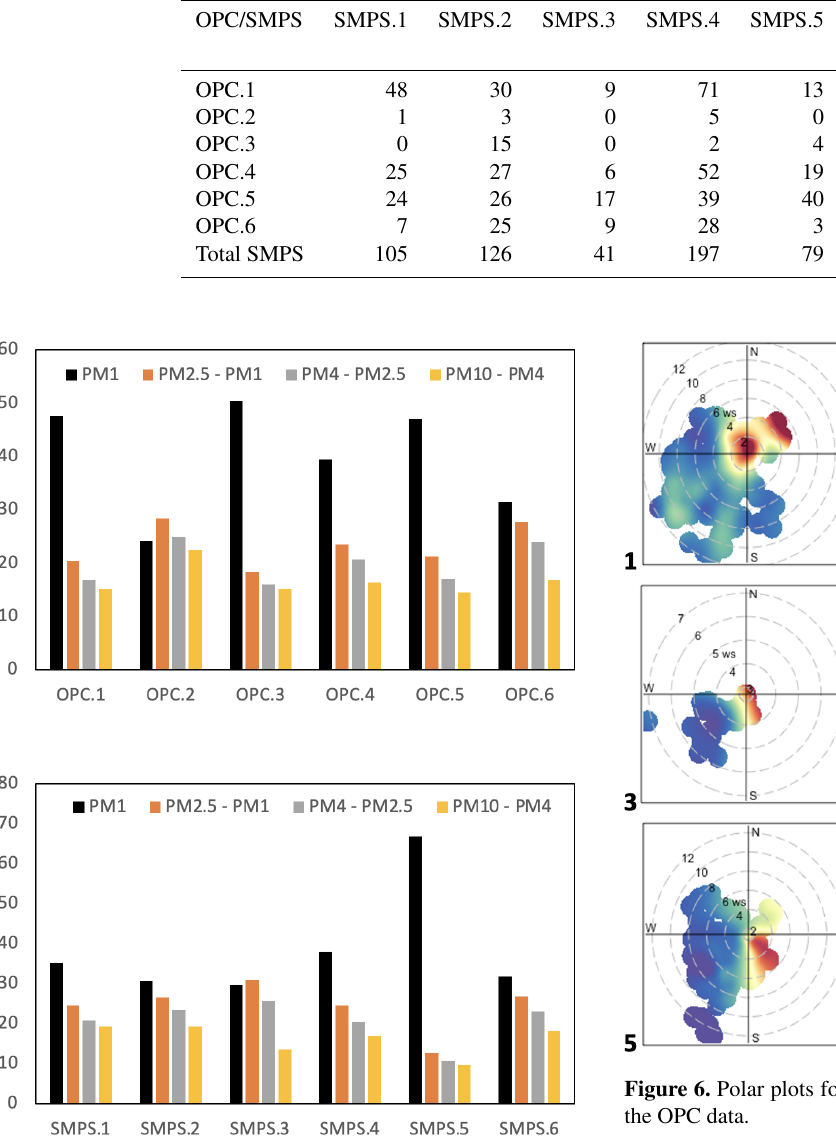
Figure 5. Particle contributions in the range up to 10µm (using the Fidas data) for the clusters formed using the OPC data (a) and the SMPS data (b) .